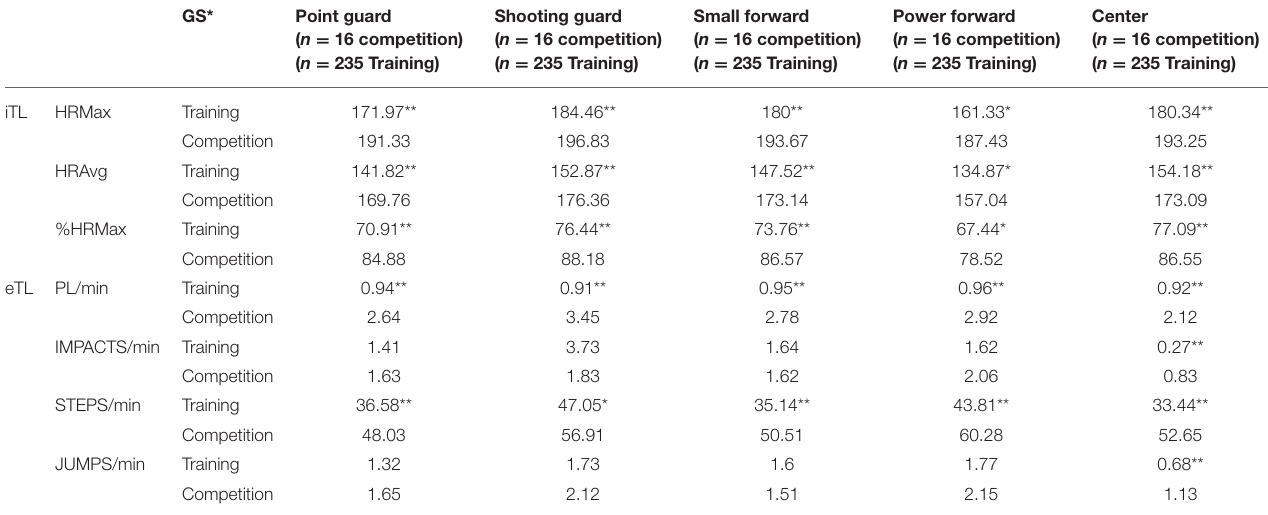
TABLE 2 | Inferential results as a function of the game situation and specific position.